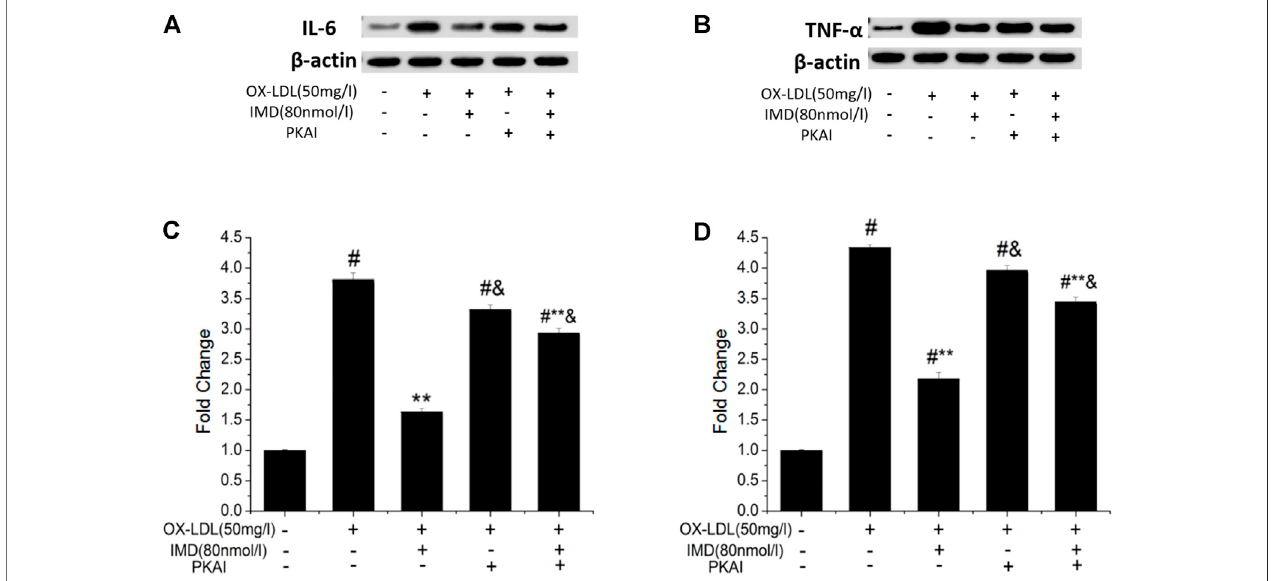
FIGURE 6 | IMD inhibits the protein expression of IL-6 and TNF- α in ox-LDL – induced macrophages (WB). # Compared with the control group ( p < 0.05); ** compared to the ox-LDL alone group ( p < 0.05); & compared to the ox-LDL +IMD group ( p < 0.05).